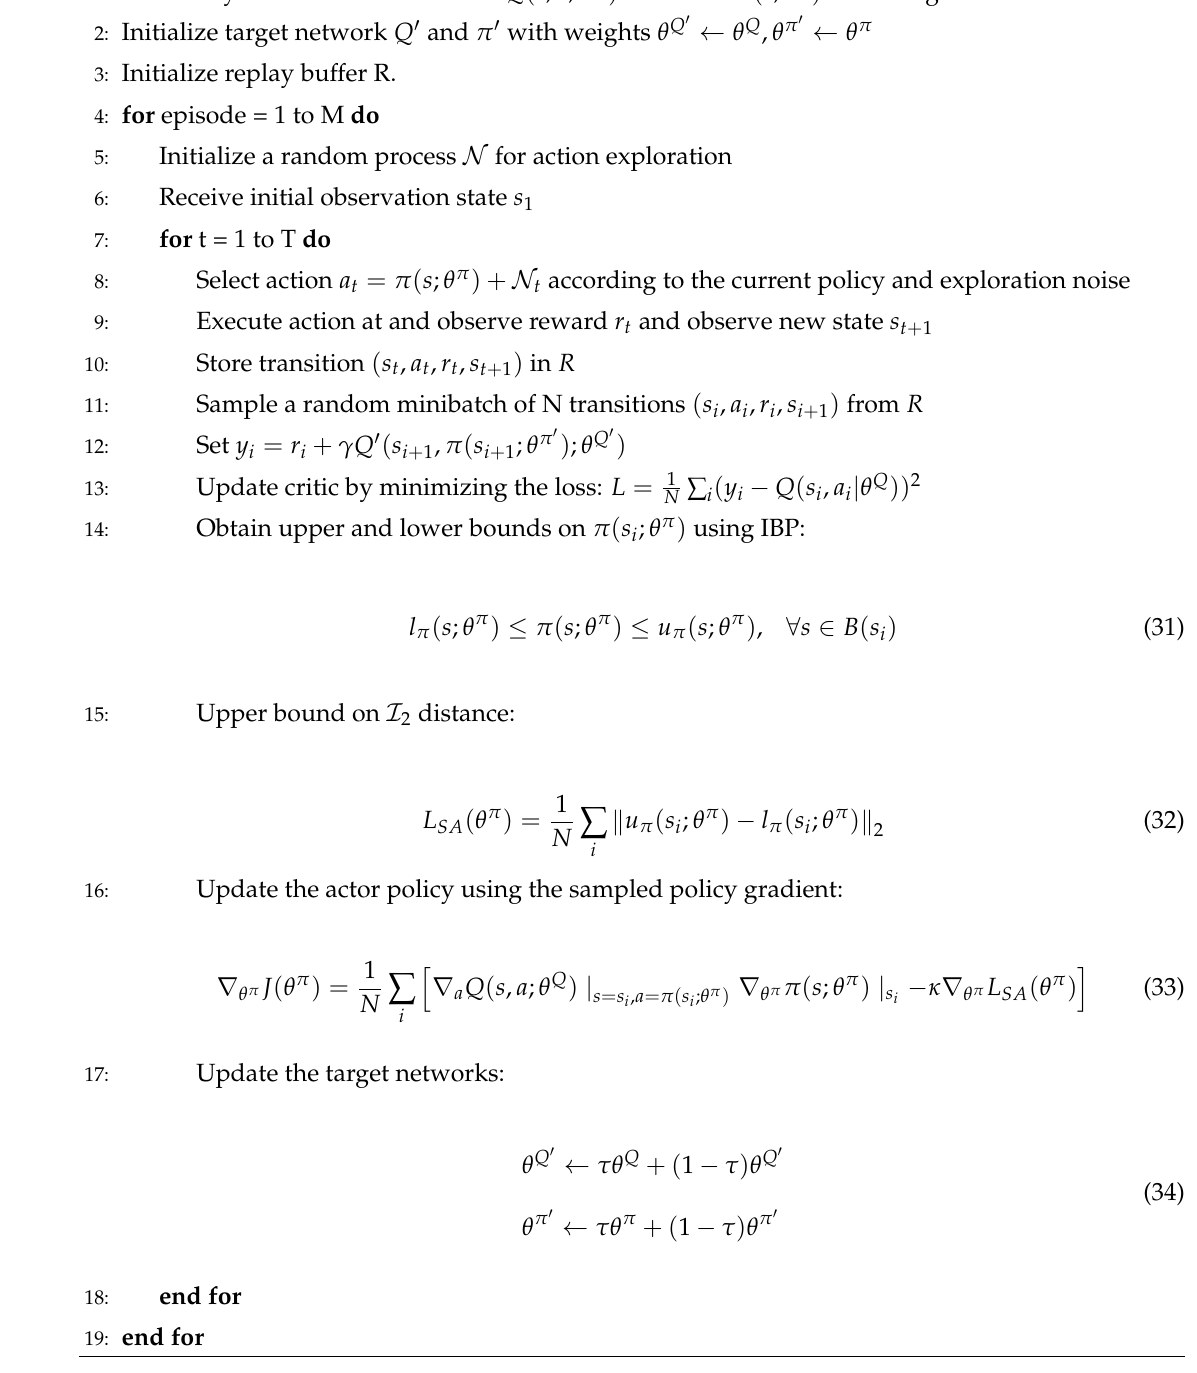
Algorithm 1 State-Adversarial Deep Deterministic Policy Gradient